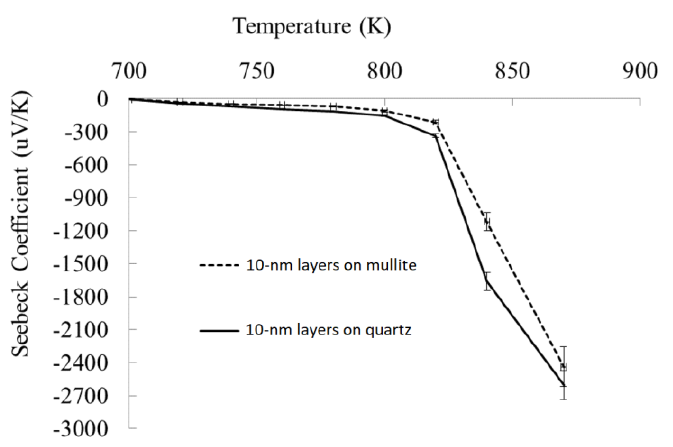
Figure 8. Seebeck coefficients of ML thin films on the mullite and the quartz substrates. Table 1. Degradation of Seebeck coefficients of ML thin films on different substrates tested at 870 K.